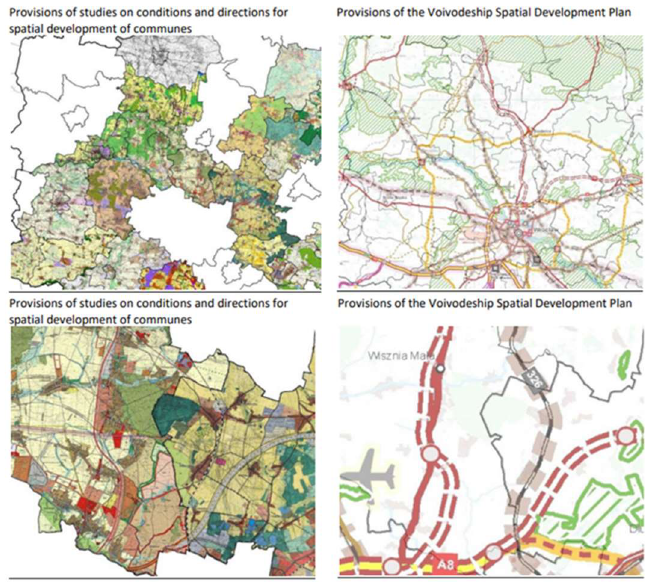
Figure 8. Provisions of municipality studies and provisions of The Voivodeship Spatial Development Plan. Resources: P. Malczewski, Institute of Territorial Development.